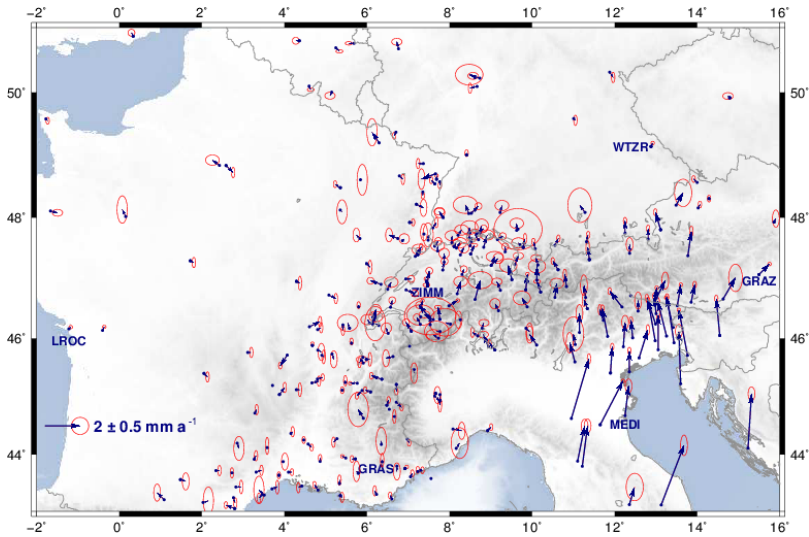
Figure 7. Horizontal station velocities relative to the Eurasian Plate with 95% error ellipses. Labels identify the reference stations used for the geodetic datum definition: GRAS (Caussols, France), GRAZ (Graz, Austria), LROC (La Rochelle, France), MEDI (Medicina, Italy), WTZR (Bad Kötzting, Germany), and ZIMM (Zimmerwald, Switzerland). Topography and bathymetry after the ETOPO1 model (Amante and Eakins,